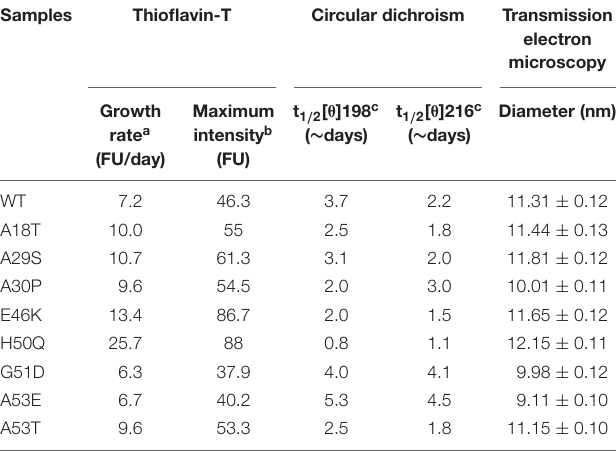
TABLE 1 | Kinetics of α -syn aggregation. Samples Thioflavin-T Circular dichroism Transmission